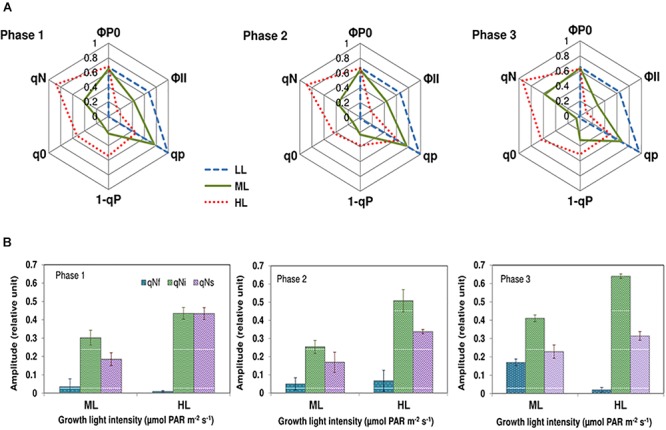
Chlorophyll fluorescence kinetic parameters during the induction and the relaxation of the nonphotochemical quenching in Phaeodactylum tricornutum grown under different light intensities and during different growth phases. (A) The fluorescence kinetic parameters during the induction of the nonphotochemical quenching. The maximum quantum yield of PSII photochemistry (ΦP0) in cells grown under different light condition and different growth phases was constant (almost 0.6), suggesting that cells were healthy. This result contrasts with the effective quantum yield of photochemical energy conversion in PSII (ΦP0), which progressively reduced from LL to HL. The photochemical quenching (qP) that quantifies the actual fraction of PSII reaction centers staying open during the illumination. qP values decreased as the light intensity increased in an antiparallel manner with 1-qP, that quantifies the fraction of closed reaction centers. The nonphotochemical quenching parameters qN and q0 reflect the excess radiation converted to heat during the actinic radiation. Under LL, qN, and q0 are close to zero, indicating that under this lighting condition, there was no excess of absorbed energy. The intensity of these parameters was higher under ML and HL, suggesting that under these photon flux densities, part of the incoming energy needed to be dissipated as heat. (B) The components qNf, qNi, and qNs during the relaxation of the nonphotochemical quenching. Light-adapted cells relaxed qN in the dark (Supplemental Data 3). The mathematical analyses of the relaxation kinetic allowed the determination of three individual components that are denoted qNs, qNi, and qNf. The intensity of qNi and qNs were always the largest in cells grown under HL whereas the intensity of qNf was the largest under ML, except in phase 2 in which the values were not significantly different. The proportion of qNi increased from phases 1 to 3. qNs was the second mostly intense components. Its amplitude decreased from phases 1 to 3 under HL while it remained constant under ML.